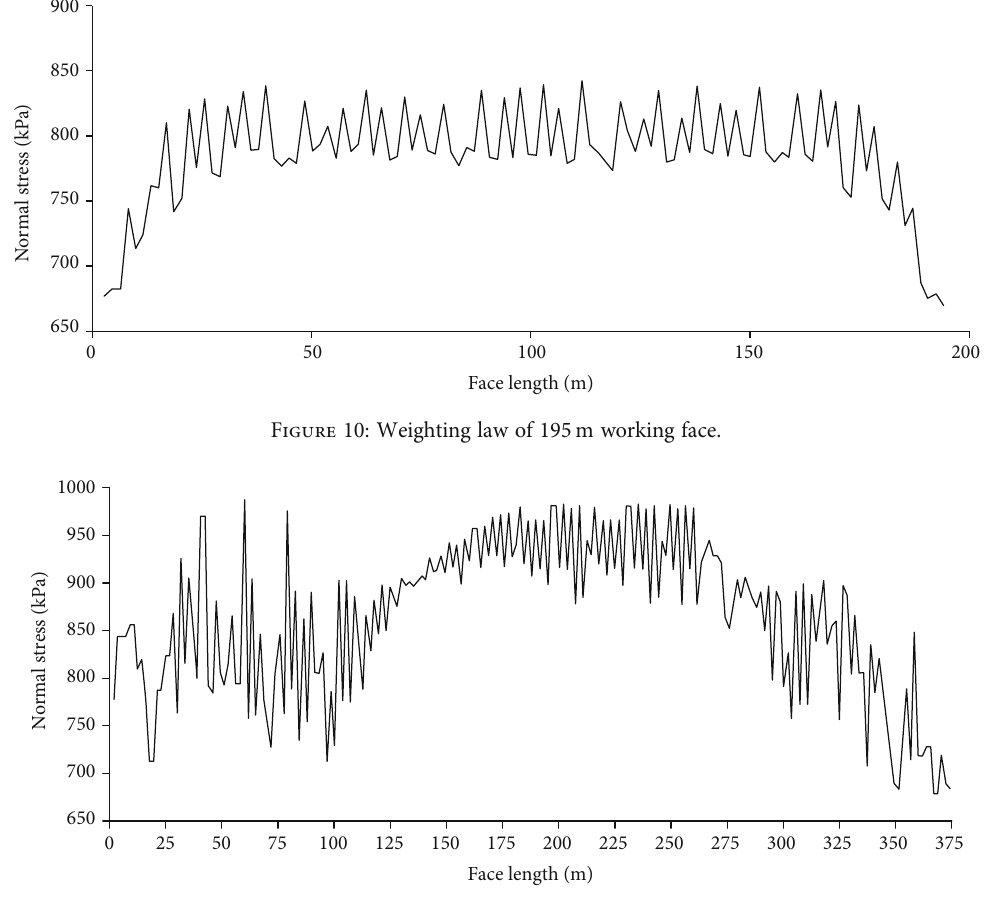
Figure 11: Weighting law of 376m working face. Table 3: Statistical results of working resistance of hydraulic support in working